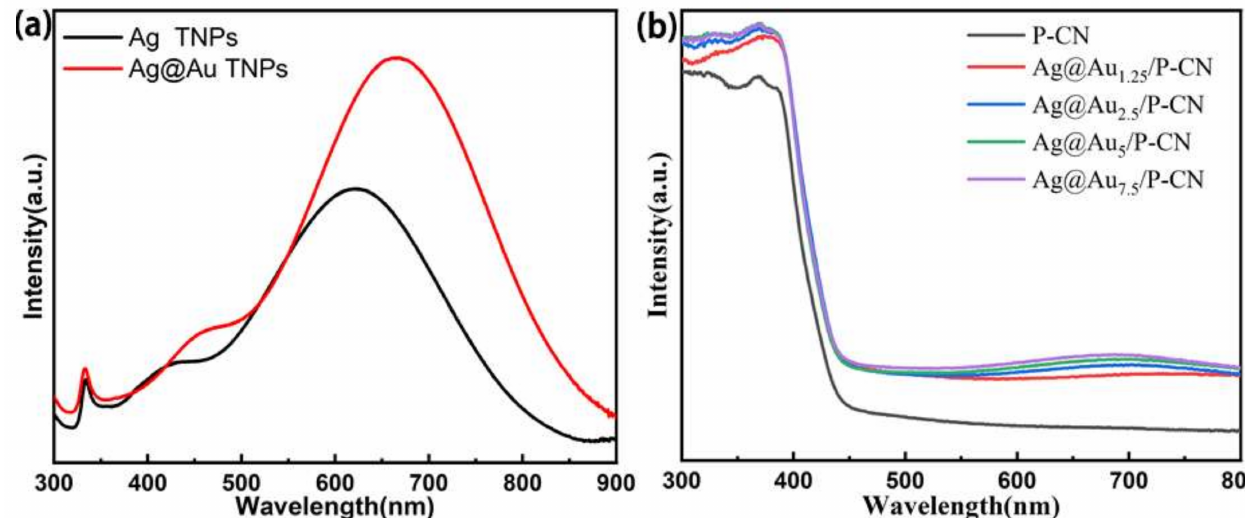
Figure 4. ( a ) UV-vis absorption spectra of Ag TNPs and Ag@Au TNPs. ( b ) UV-vis absorption spectra of the system with P–CN and Ag@Au 1.25 /P–CN, Ag@Au 2.5 /P–CN, Ag@Au 5 /P–CN, Ag@Au 7.5